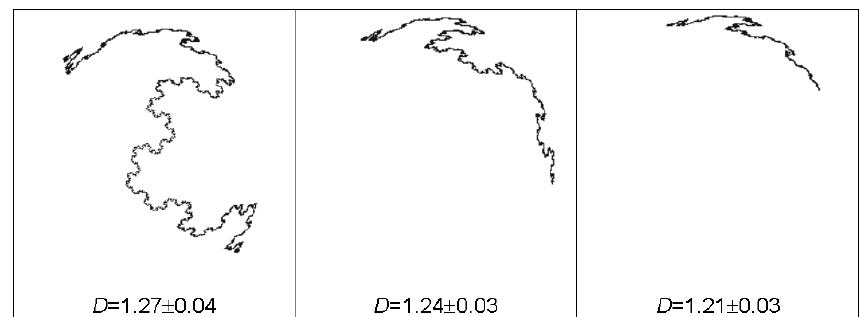
Fig. 6. Testing of dependence of the box-counting dimension on structure